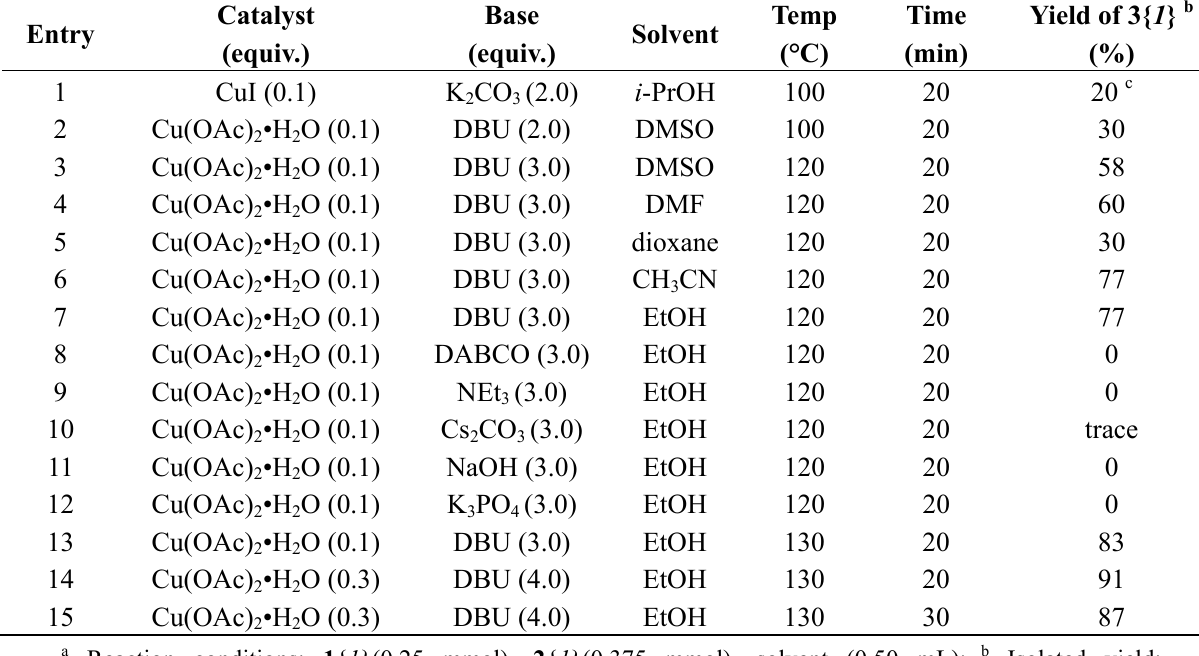
Table 1. Optimization for the synthesis of ( Z )-2-benzyl-3-benzylideneisoindolin-1-one a